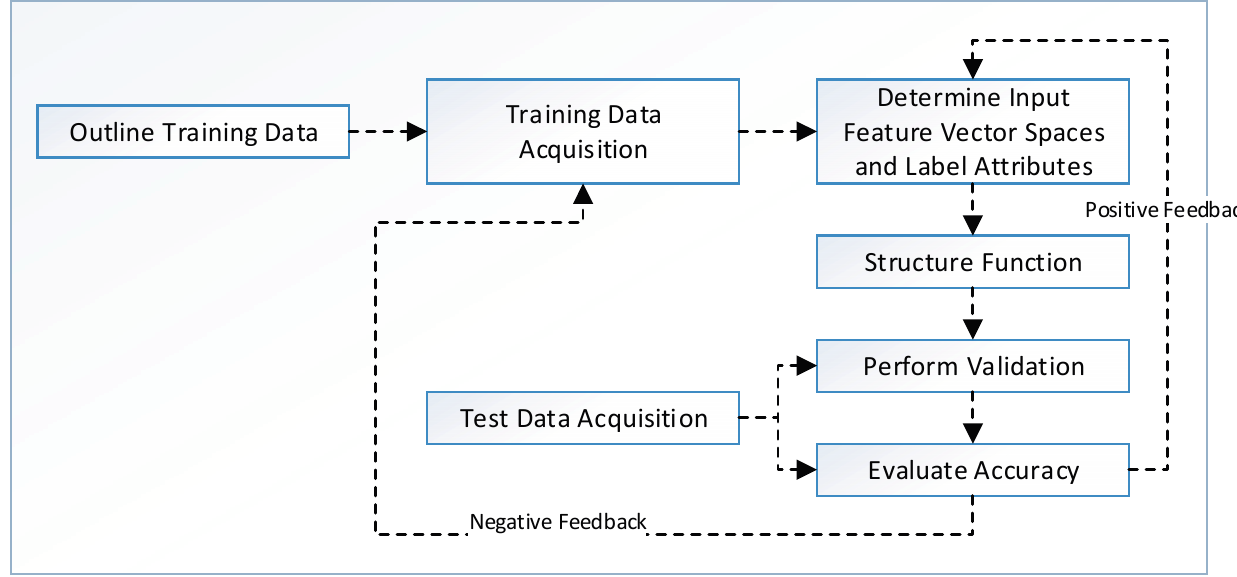
Figure 5. SSL algorithm development